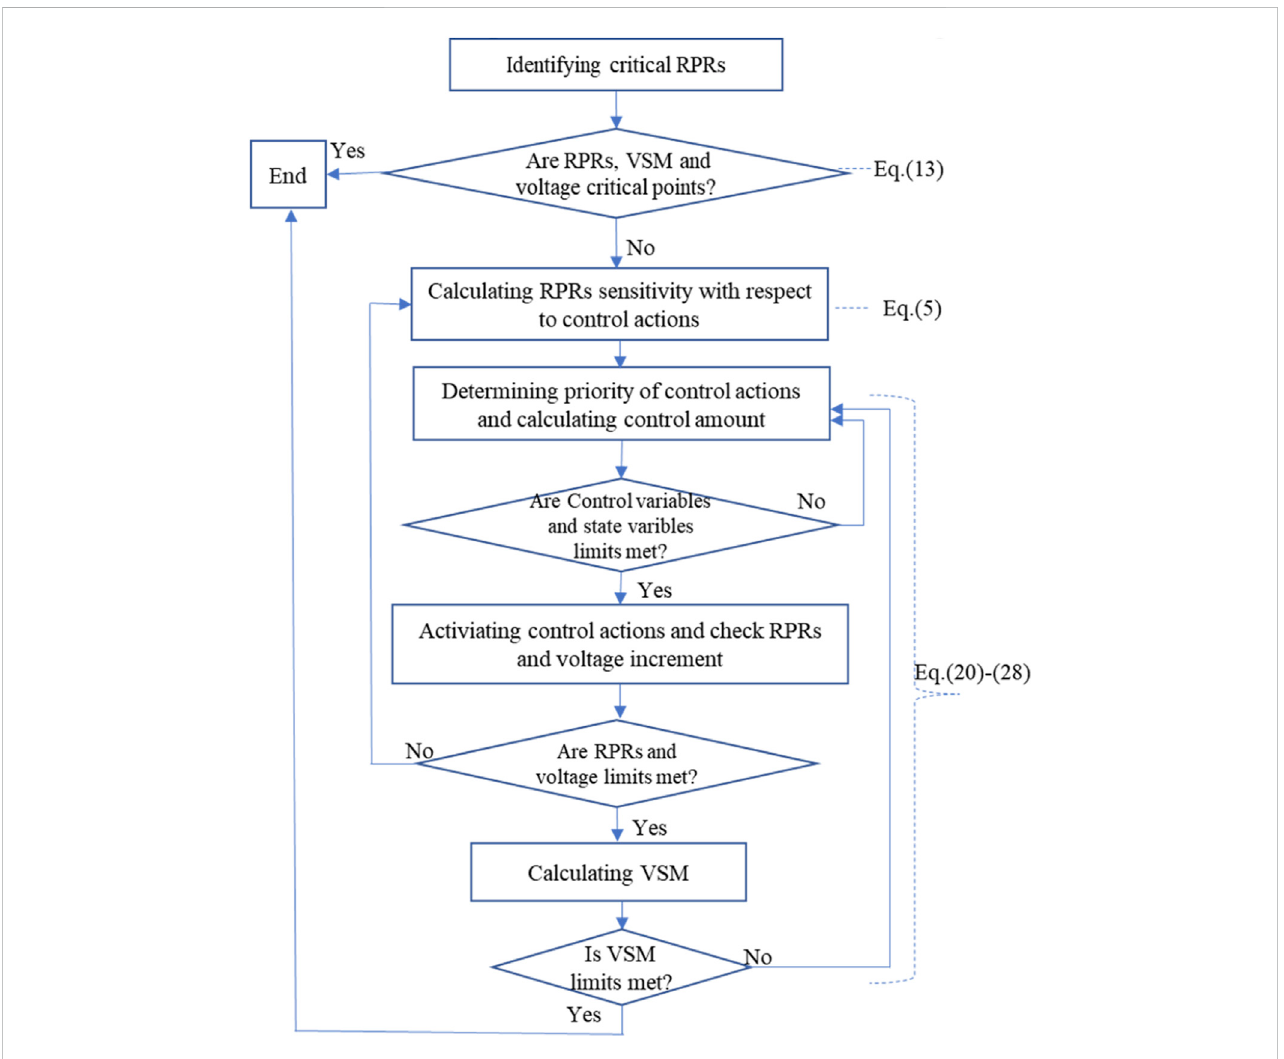
FIGURE 4 Flow chart for solving minimum control